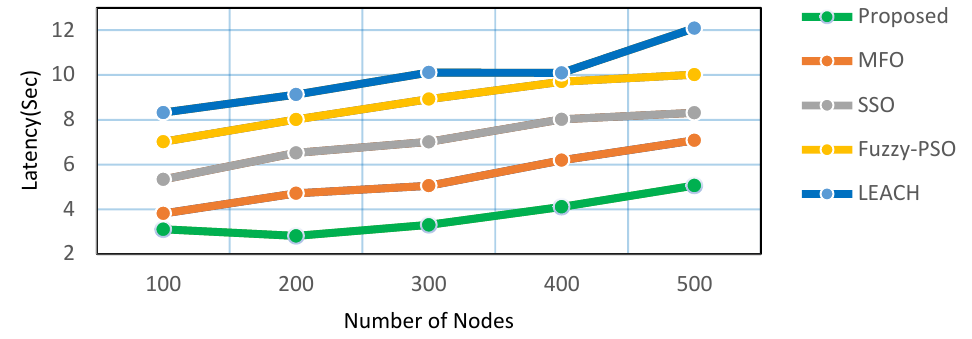
Figure 6. Analysis of latency vs. number of nodes. Table 6. Comparison of latency with various routing